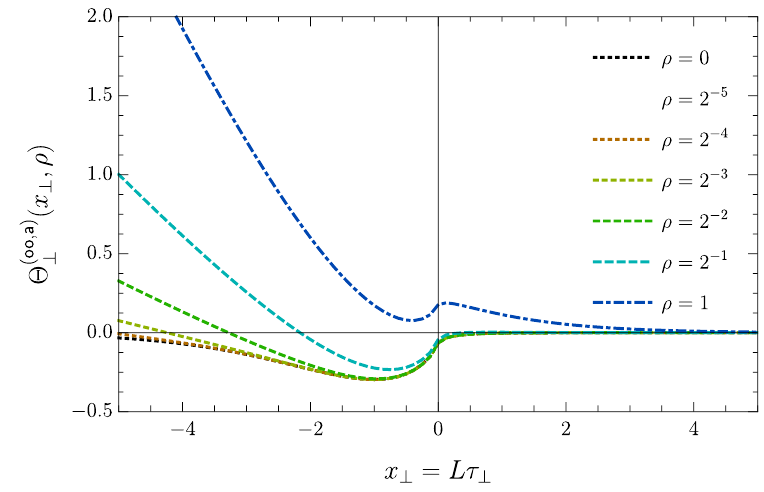
( oo , a ) ( x ρ ) for different values of the aspect ratio Figure 9: Scaling function Θ ⊥ , ⊥ ρ ≤ 1. With shrinking aspect ratio the influence of the domain wall vanishes and thus the function converges to the same limiting case as the periodic open cylinder, ( oo ) ( x ) , see (2.56), which leads to a change in the sign where the two namely Θ ⊥ ⊥ behaviours compete against each